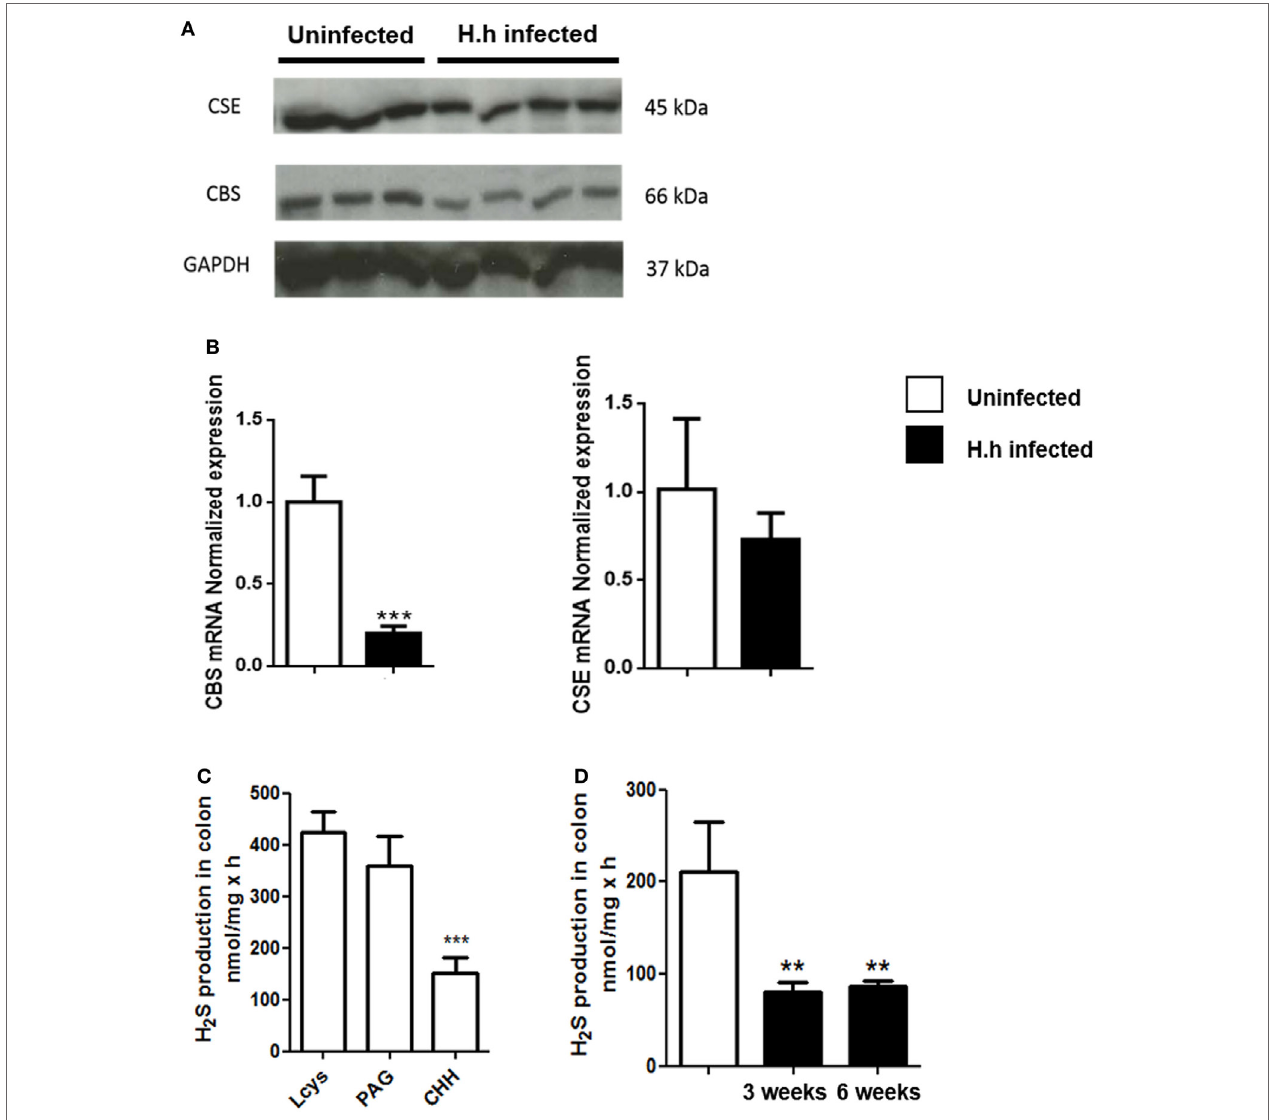
FigUre 2 | H 2 S production is significantly reduced during Helicobacter hepaticus ( Hh )-induced colitis. 129SvEv Rag2 − / − mice were infected with Hh and sacrificed 6 weeks post-infection. (a) Representative western blot and (B) relative CSE and CBS mRNA expression performed on colon samples from uninfected and Hh -infected mice. A significant reduction in the expression of both CBS protein and mRNA was observed in Hh -infected mice. (c) H 2 S synthesis by the colon of healthy mice was measured in colon homogenates, in the absence or presence of CBS inhibitor [(CHH), 3 mmol/L] or CSE inhibitor (PAG, 10 mmol/L). The substrate for H 2 S synthesis ( l -cys) was present at 4 mmol/L. Only CHH significantly reduced H 2 S synthesis in tissue from healthy controls (*** P < 0.001 vs. l -cys alone). (D)